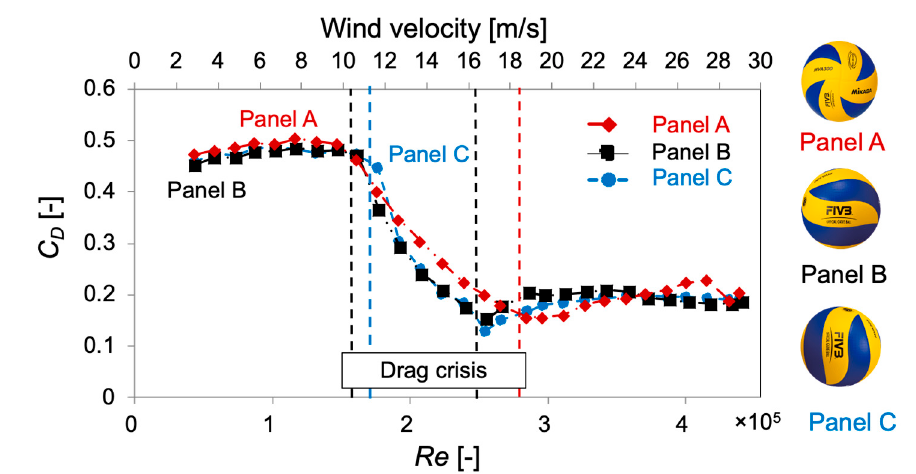
Figure 5. Relationship between Reynolds number and Drag coefficient on MVA200.